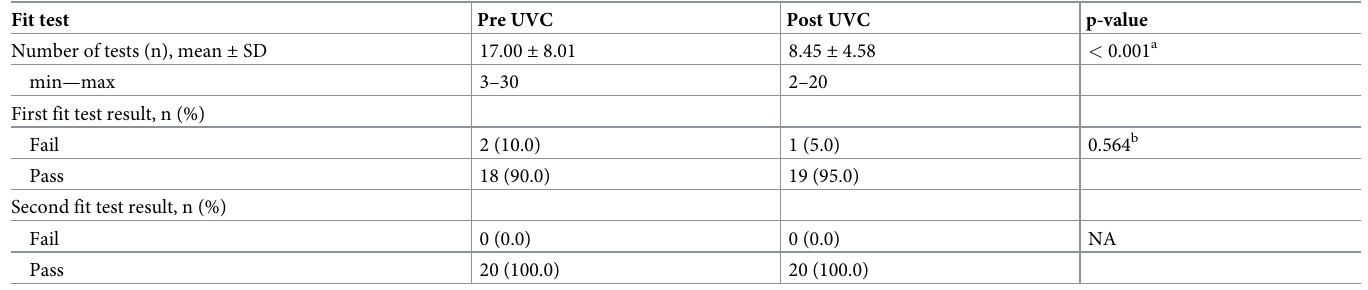
Table 5. Result of fit test.